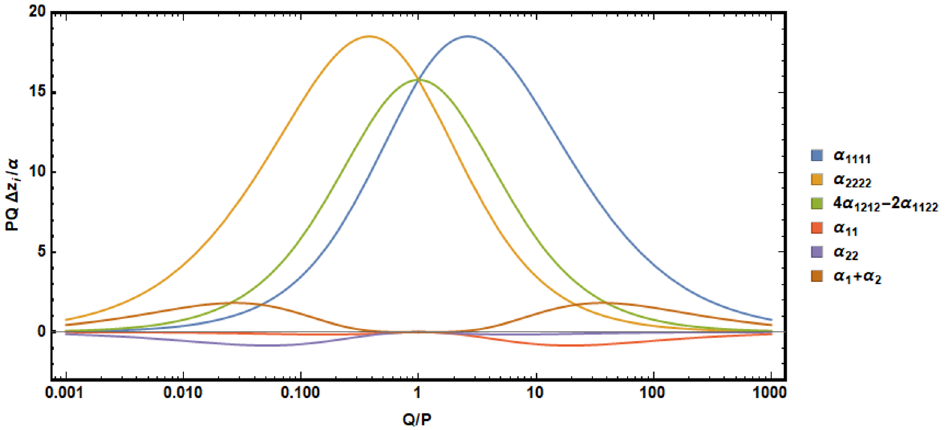
Figure 1 . (Rescaled) individual contributions to z ext from each terms in the SL( 2 , R )-invariant action. The preserved electromagnetic duality ( Q ↔ P and 1 ↔ 2 ) is clear from the symmetry about the Q = P